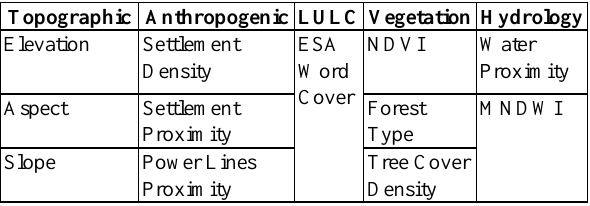
Table 2. Input features implemented in the study.